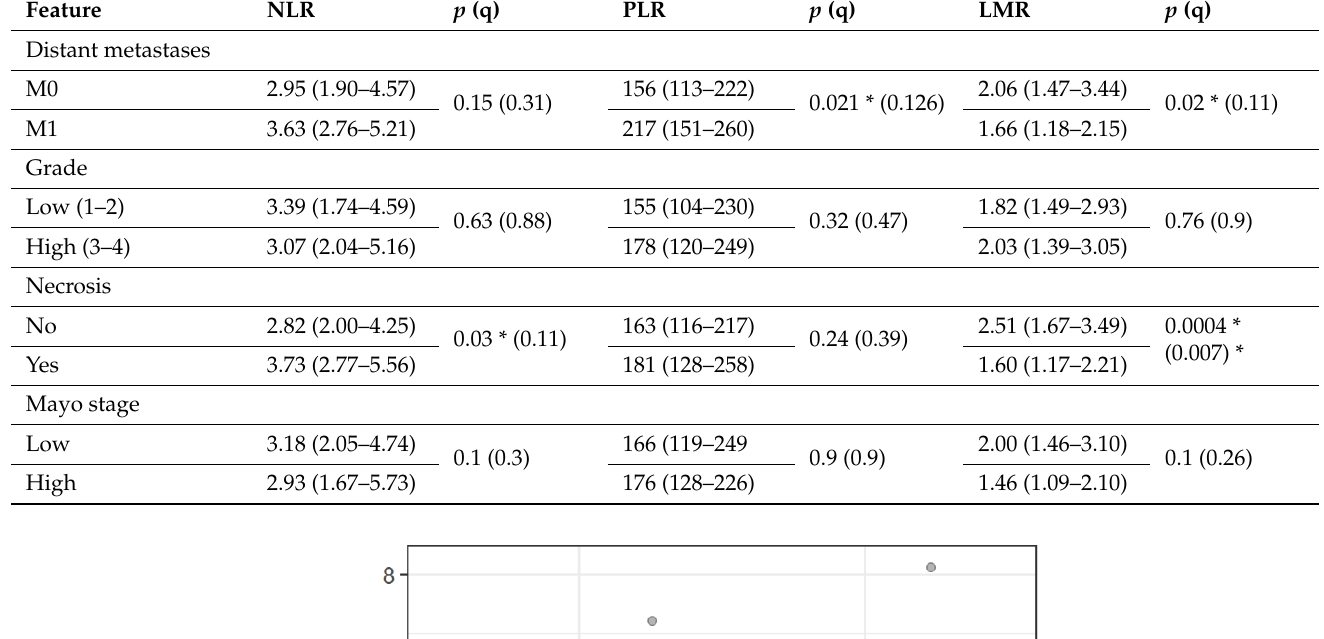
ROC and areas under the